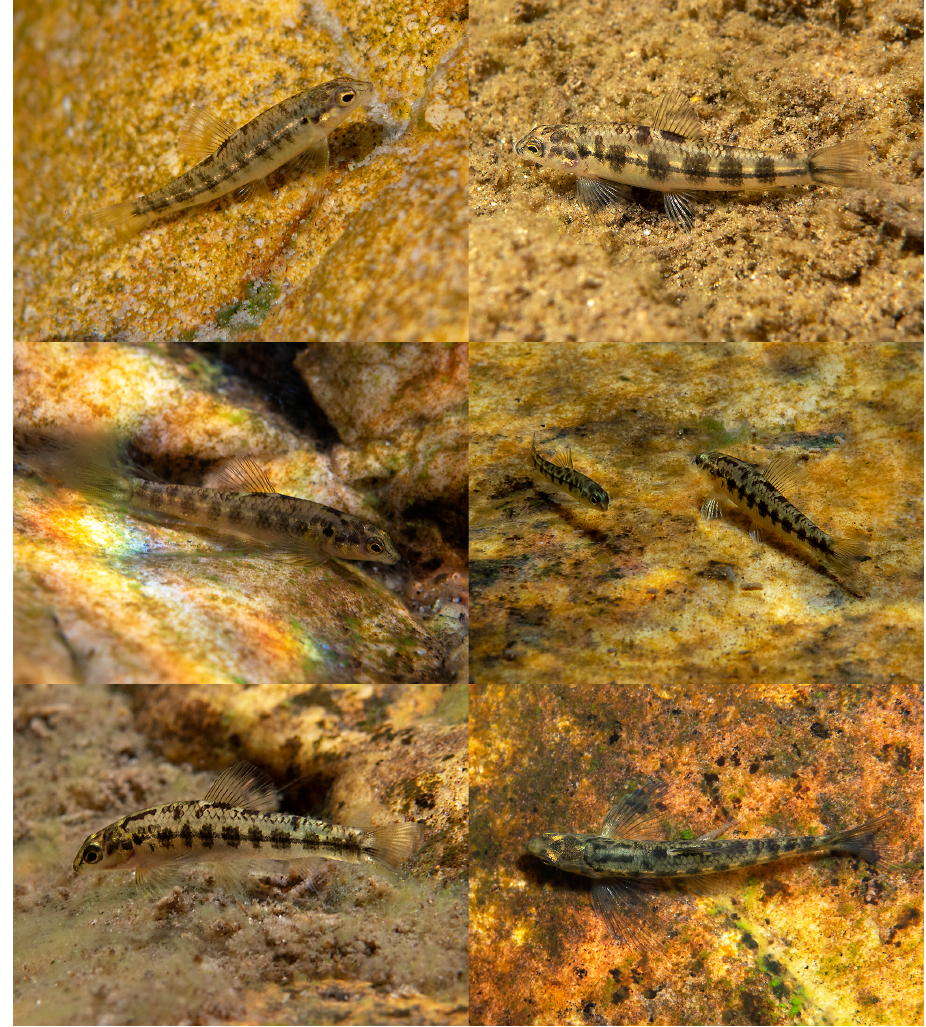
FIGURE 6 | Underwater photography of Characidium kalunga in the rio Preto, at the Parque Nacional da Chapada dos Veadeiros, Goiás, Brazil (not